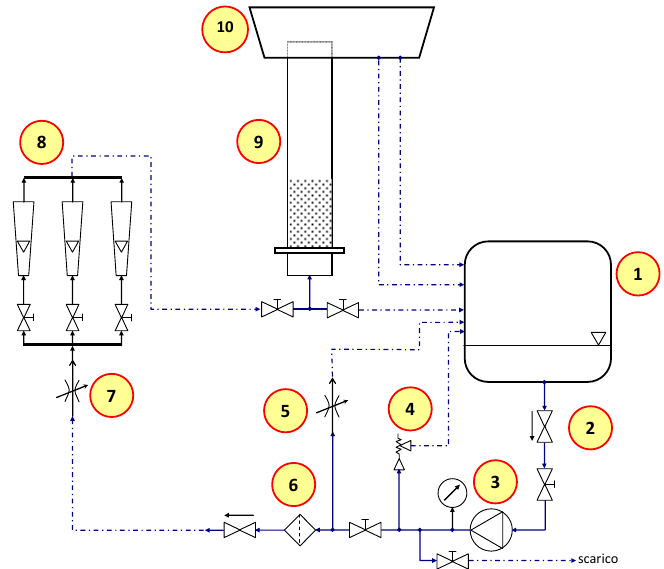
Figure 3. Experimental water-fluidization rig. 1. Tank; 2. Check valve; 3. Pump; 4. Overpressure valve; 5. By-pass valve; 6. Filter; 7. Fine regulation valve; 8. Rotameters; 9. Fluidization column (10 cm ID, 1.75 m height); 10. Collection tank.